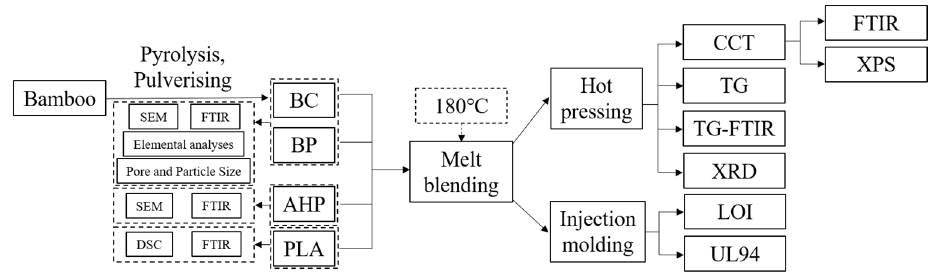
Figure 1. Flowchart diagram showing preparation and tests of the composites.